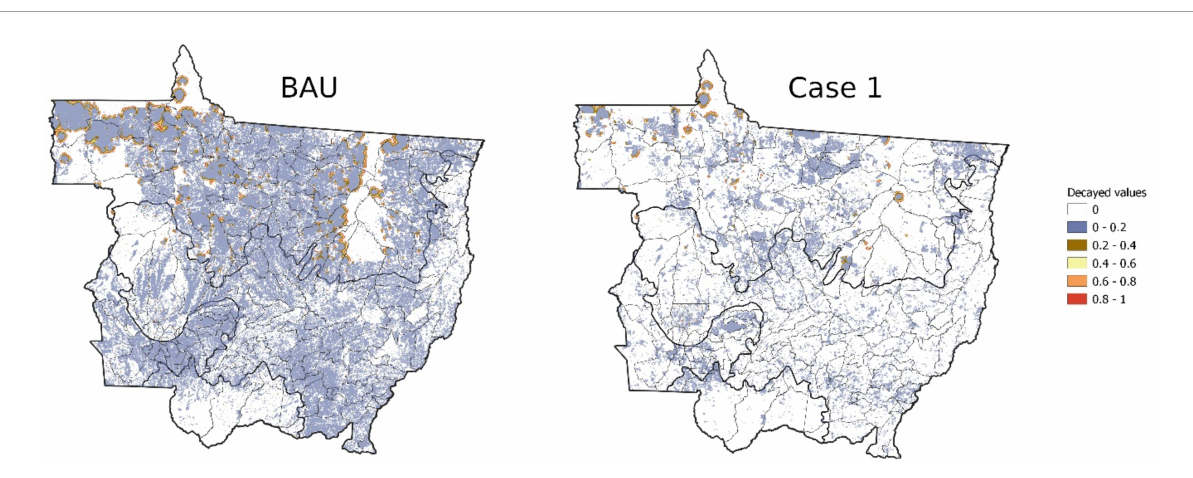
FIGURE14 Comparison of the BAU scenario (left) and Case 1 scenario for 2050 (right)